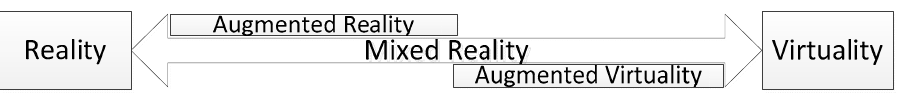
Figure 2. A representation of mixed reality (MR) and reality–virtuality- (RV)-continuum.